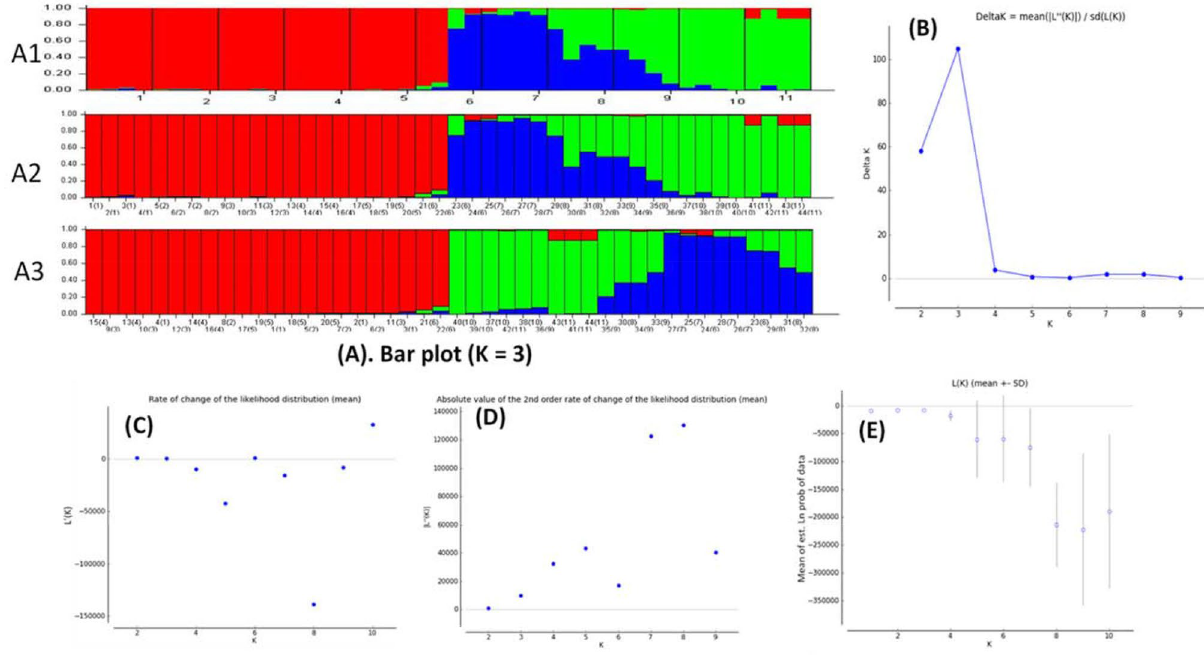
Figure 9. Structure harvester and Delta K value elucidated using Evano et al. 53 method and Bayesian model- based valuation of population structure for 44 V . subterranea accessions based on ISSR markers. (A) Bar plot: (A1) based on original population order, (A2) based on genotype ID (population) order, (A3) based on estimated membership coefficients values (Q); (B) ΔK = mean (|L”(K)|)/sd(L(K)) here, ΔK = 3 indicates the maximum K value; (C) rate of change of the likelihood distribution (mean); (D) absolute value of the 2nd order rate of change of the likelihood distribution (mean); (E) mean of estimated Ln probability. Each vertical line represents an accession and different color represents the estimated membership coefficients (Q) to the respective group. The red, purple, and yellow colors represent the members of 3 groups or clusters inferred by STRU CTU RE harvester. The numbers at the base of each vertical line indicate the accession ID numbers according to the Table 1. The values inside the parentheses indicate the eleven species sources as follow: 1, 2, 3, 4, 5, 6, 7, 8, 9, 10 and 11 represents the Duna, Maikai, Cancaraki, Roko, Bidillali, Jatau, Maibergo, Katawa, Karu and Exsoskoto,